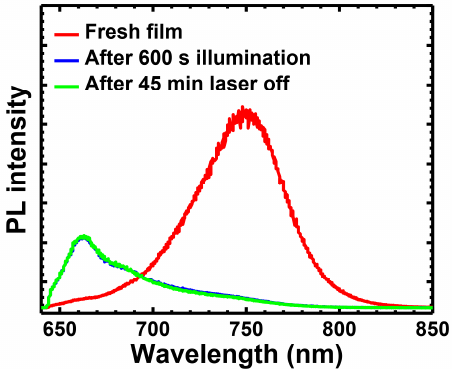
Figure 2. The PL spectrum of quasi-2D perovskites of PEA 2 MA 2 Pb 3 I 10 at various illumination times under continuous illumination with an excitation intensity of 1200 mW/cm 2 using a 635-nm laser source in an ambient environment.